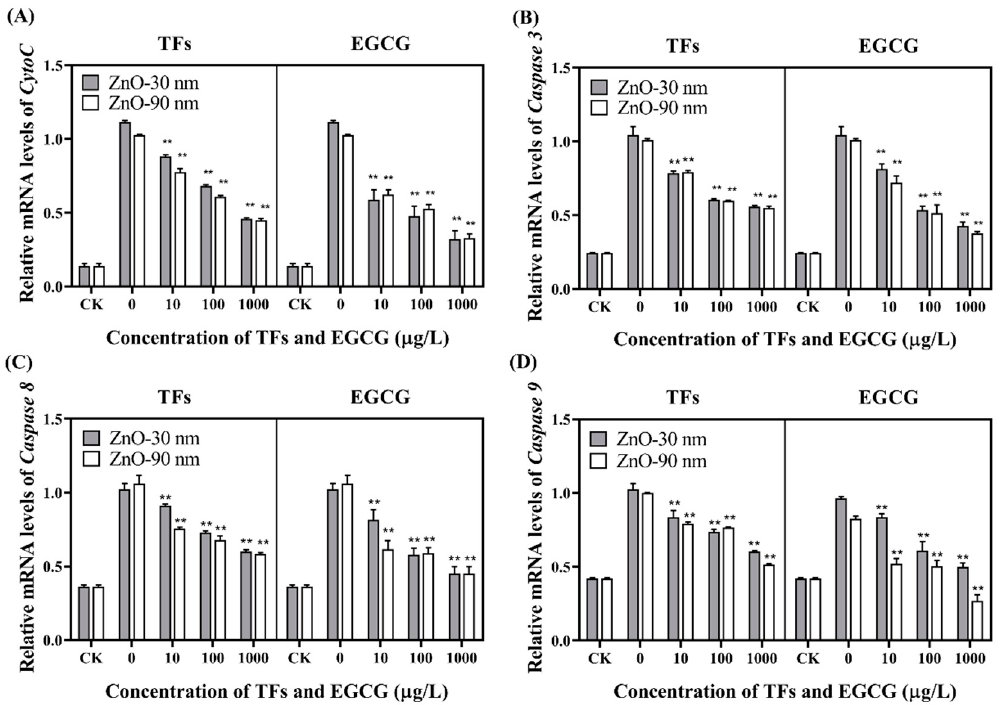
Figure 4. Apoptosis-related gene expression of CytoC ( A ), Caspase 3 ( B ), Caspase 8 ( C ), and Caspase 9 ( D ). Different concentrations of TFs and EGCG (10, 100, and 1000 μ g/L) treatment after 100 μ g/L of 30 nm or 90 nm ZnO-NPs exposure in RTE cells for 12 h. CK was blank group (the group with neither sample nor NPs treatment). The data was represented as the means ± standard deviation. The asterisks denoted responses that were significantly different from those of the 0 μ g/L group (** p < 0.01).